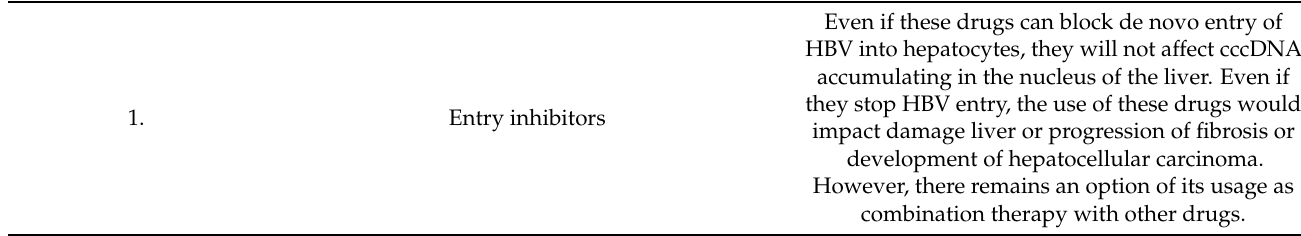
Table 3. Visible limitation of innovative drugs targeting viral